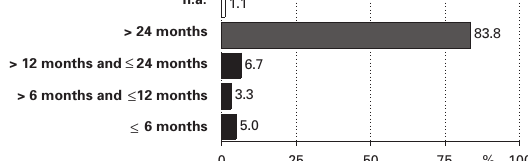
Intended duration of medication in 698 patients with schizo- phrenic